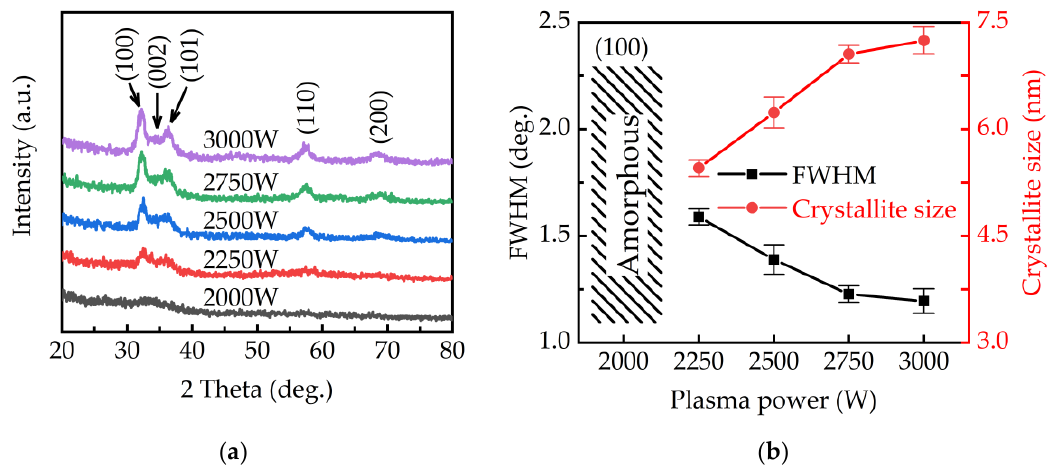
Figure 6. ( a ) The XRD spectra of GaN films and ( b ) the FWHM and crystalline size of GaN films obtained at different plasma powers.